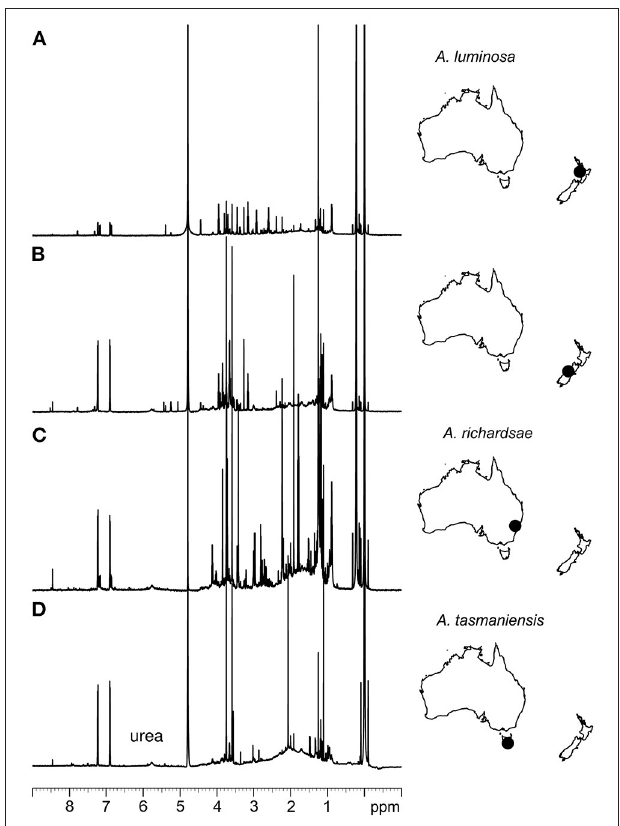
FIGURE 3 | 1 H NMR spectroscopic analysis of glowworm adhesives. (A) Spectrum of isolate from New Zealand glowworms ( A. luminosa , North Island). (B) Spectrum of isolate from New Zealand glowworms ( A. luminosa , South Island). (C) Spectrum of isolate from Australian glowworms ( A. richardsae from Newnes, NSW). (D) Spectrum of isolate from Tasmanian glowworms ( A. tasmaniensis